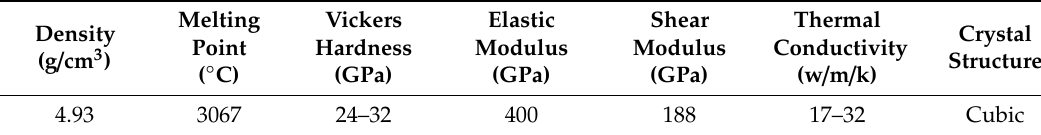
Table 2. Properties of titanium carbide nanoparticles